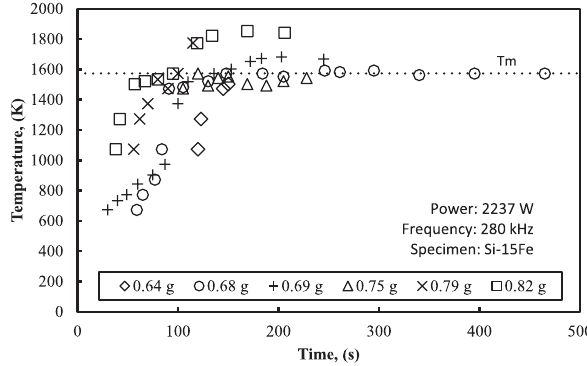
Fig. 6: Levitation of a silicon alloy droplet